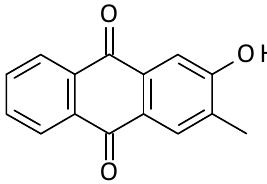
Figure 3. Anthraquinones from Alternanthera philoxeroides.